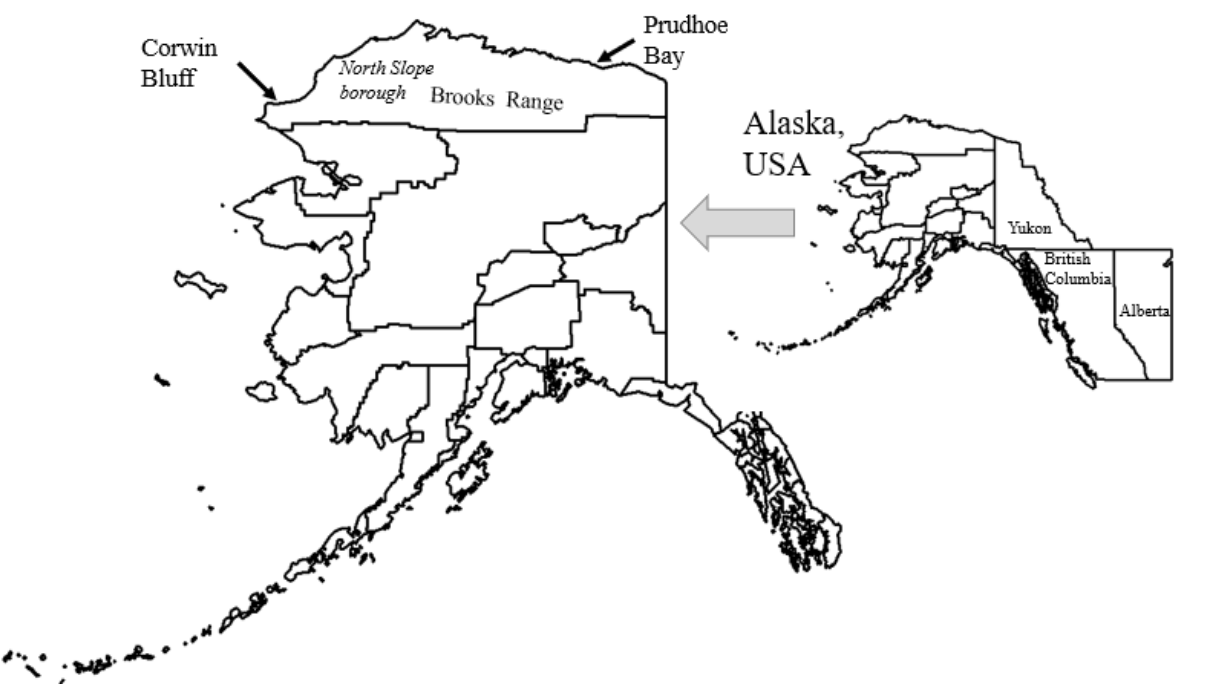
Figure 13. Location of Alaska with respect to the Canadian provinces of Alberta and British Columbia (coalfields discussed below) and Yukon Territory. The North Slope coal deposits are outlined by Corwin Bluff, the Brooks Range, Prudhoe Bay, and the Arctic Ocean (to the north).